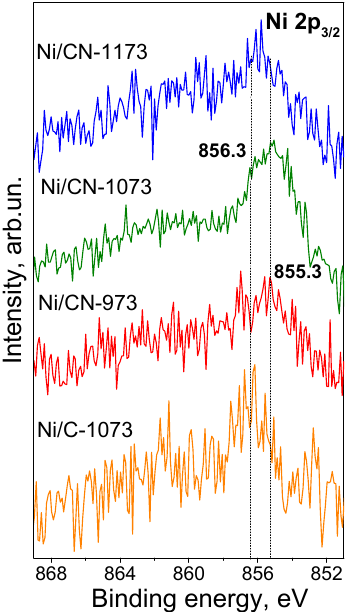
Figure 5. Ni 2p 3 / 2 X-ray photoelectron spectra of the Ni catalysts after the reaction. Figure 5. Ni 2p 3/2 X-ray photoelectron spectra of the Ni catalysts after the reaction.